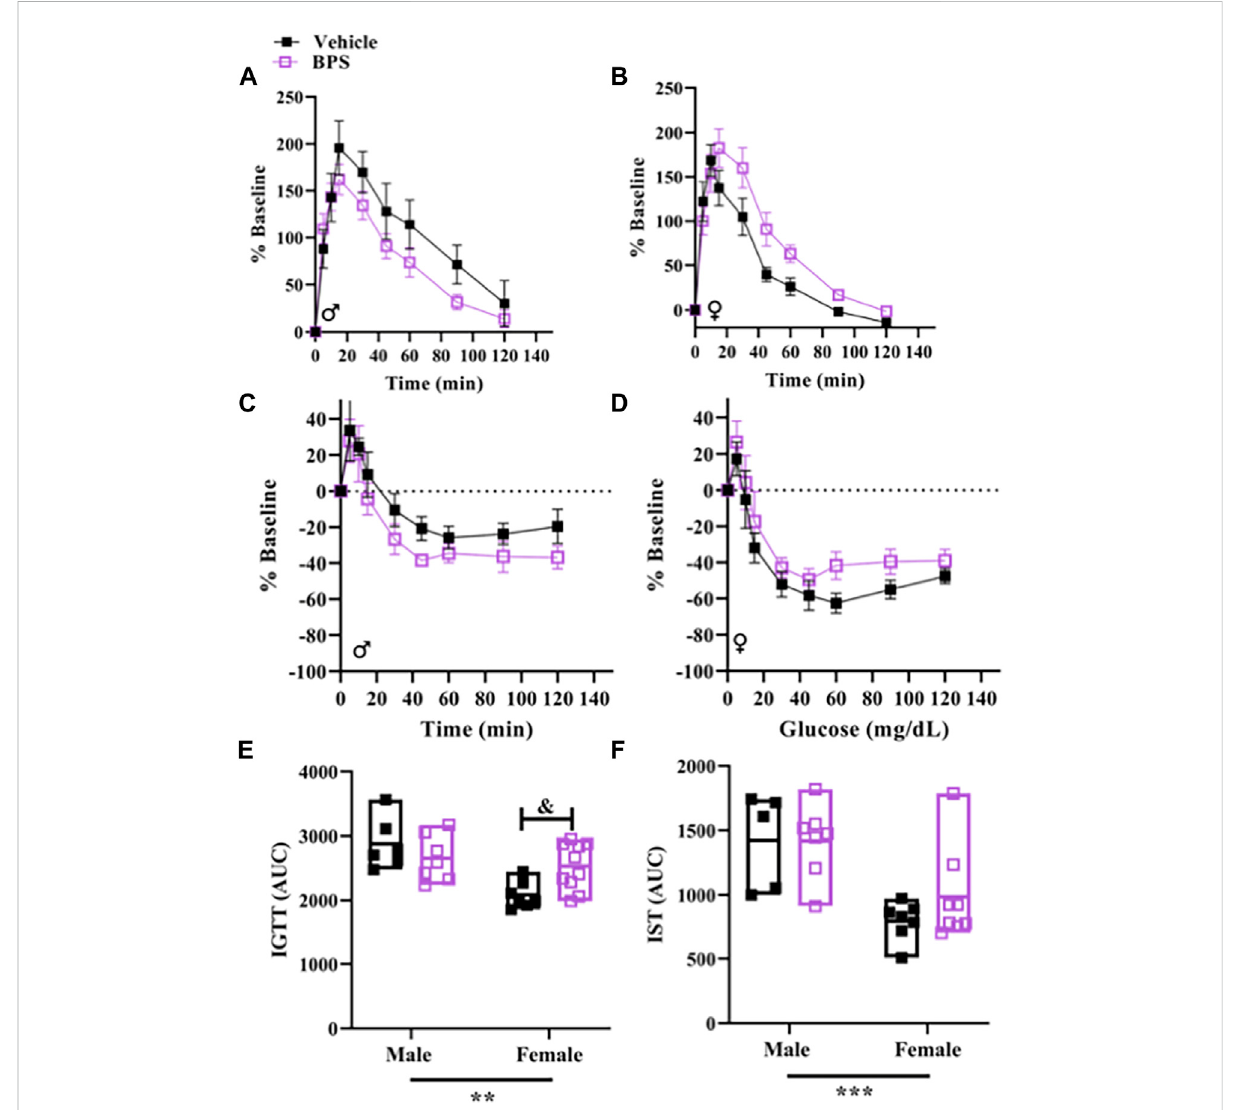
FIGURE 6 Glucose tolerance is impaired in female offspring born to BPS-exposed dams. Intraperitoneal glucose tolerance tests (IGTT) and insulin sensitivitytests(IST)wereperformedinadultoffspring. (A) Serialglucosemeasurementsinadult (A) maleor (B) femalemicechallengedwithglucose. Serialglucoselevelsinadult (C) maleor (D) femalemicechallengedwithinsulin. (D) Serialglucosemeasurementsinadultmalemicechallengedwith insulin.Areaunderthecurve(AUC)for (E) IGTTor (F) IST.AUCwerecomparedbyTwo-wayANOVAwithSidak ’ sposthoctest.** p < 0.01;*** p < 0.001 sex as a signi fi cant source of variation. & p < 0.05 BPS vs.